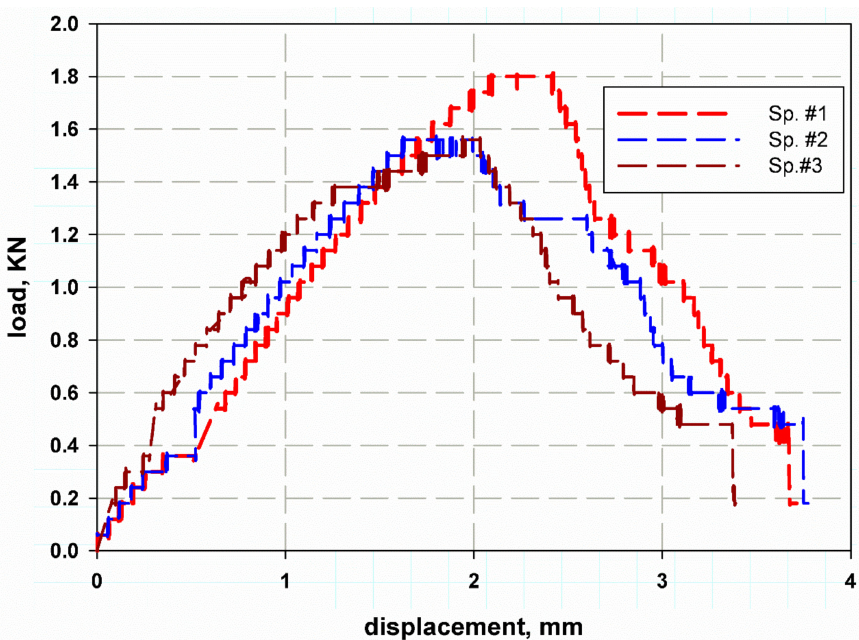
Figure 10. Load–displacement curve of different compact tension specimens. After substituting these reduction data, Young’s modulus was calculated to be 35.15 GPa, which is very close to the average experimental Young’s modulus (32.75 GPa). The optically observed failure crack length reached 22.5 mm. The average fracture toughness ( K IC ) was √ √ m ) with a standard deviation 142.5 ( MPa m ). The average measured as 2322 ( MPa surface release energy ( G IC ) is 153.6 kJ/m 2 with a standard deviation 22.53 kJ/m 2 . It was observed that the fiber bridged the two faces of cracks, and the crack advanced straight through the precrack direction, owing to the high-stress intensity factor induced at the crack tip. The existence of cracks in the pipe surface or even macrocracks may be harmful and cause leakage of the petroleum waste fluids into the pipe core quartz particles, which can be dangerous [2]. Fiber pull out, fiber fracture, fiber bridging, and matrix cracking, are shown in Figure 11. The sand quartz has the major role in this trend of behavior. The sand core material in the cylinder is distinguished by high stiffness and brittleness, especially when combined by epoxy resin. The curvature of the specimen had a dominating role in the increase of the fracture toughness values. The curvature of the specimen redistributed the loading stress through the cross-section of the tested specimens.